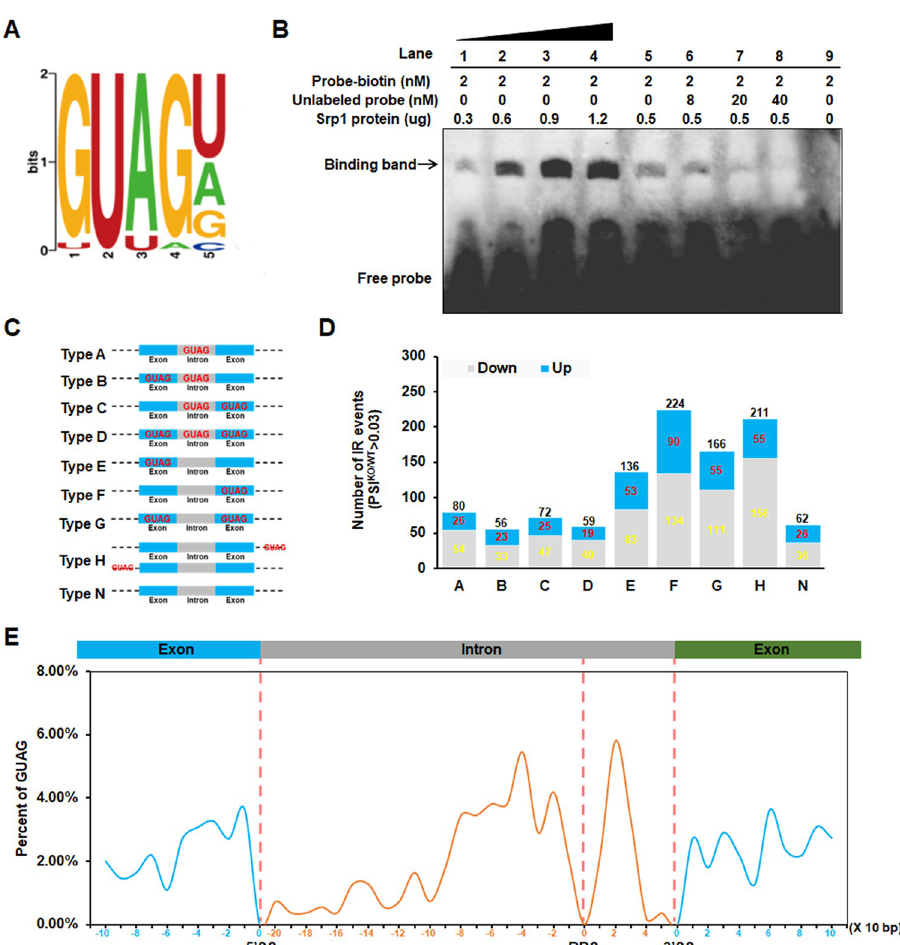
Fig 5. MoSrp1 binds to the GUAG consensus in pre-mRNAs. (A) Bit image of the top MoSrp1-binding motif by analyzing the RIP-Seq data. (B) RNA-EMSA assay showing the binding of MoSrp1 to the GUAG consensus. Lane 1–4: 2 nM biotin-tagged RNA fragment of 5’-GUAG-3’ with increased amount of MoSrp1 (0.3, 0.6, 0.9, and 1.2 μ g); Lane 5–8: 2 nM biotin-tagged RNA fragment and 0.5 μ g MoSrp1 with increased amount of unlabeled RNA oligomer (0, 8, 20, and 40 nM); Lane 9: 2 nM biotin-tagged 5’-GUAG-3’ RNA fragment without unlabeled RNA oligomer and MoSrp1. MoSrp1 was expressed and purified from E . coli , and the arrow indicates the binding band. (C) Different types (Type A to N) of aberrantly spliced transcripts with or without the GUAG consensus in the introns and their neighboring exons. A total of 1,066 introns retained in the Δ Mosrp1 mutant srp1ko1 were used for analysis. (D) The number of intron retention events with PSI > 0.03 in srp1ko1 in comparison with WT P131. The number of introns with up- and down-regulated PSI was shown in red and yellow, respectively. (E) Distributions of the GUAG